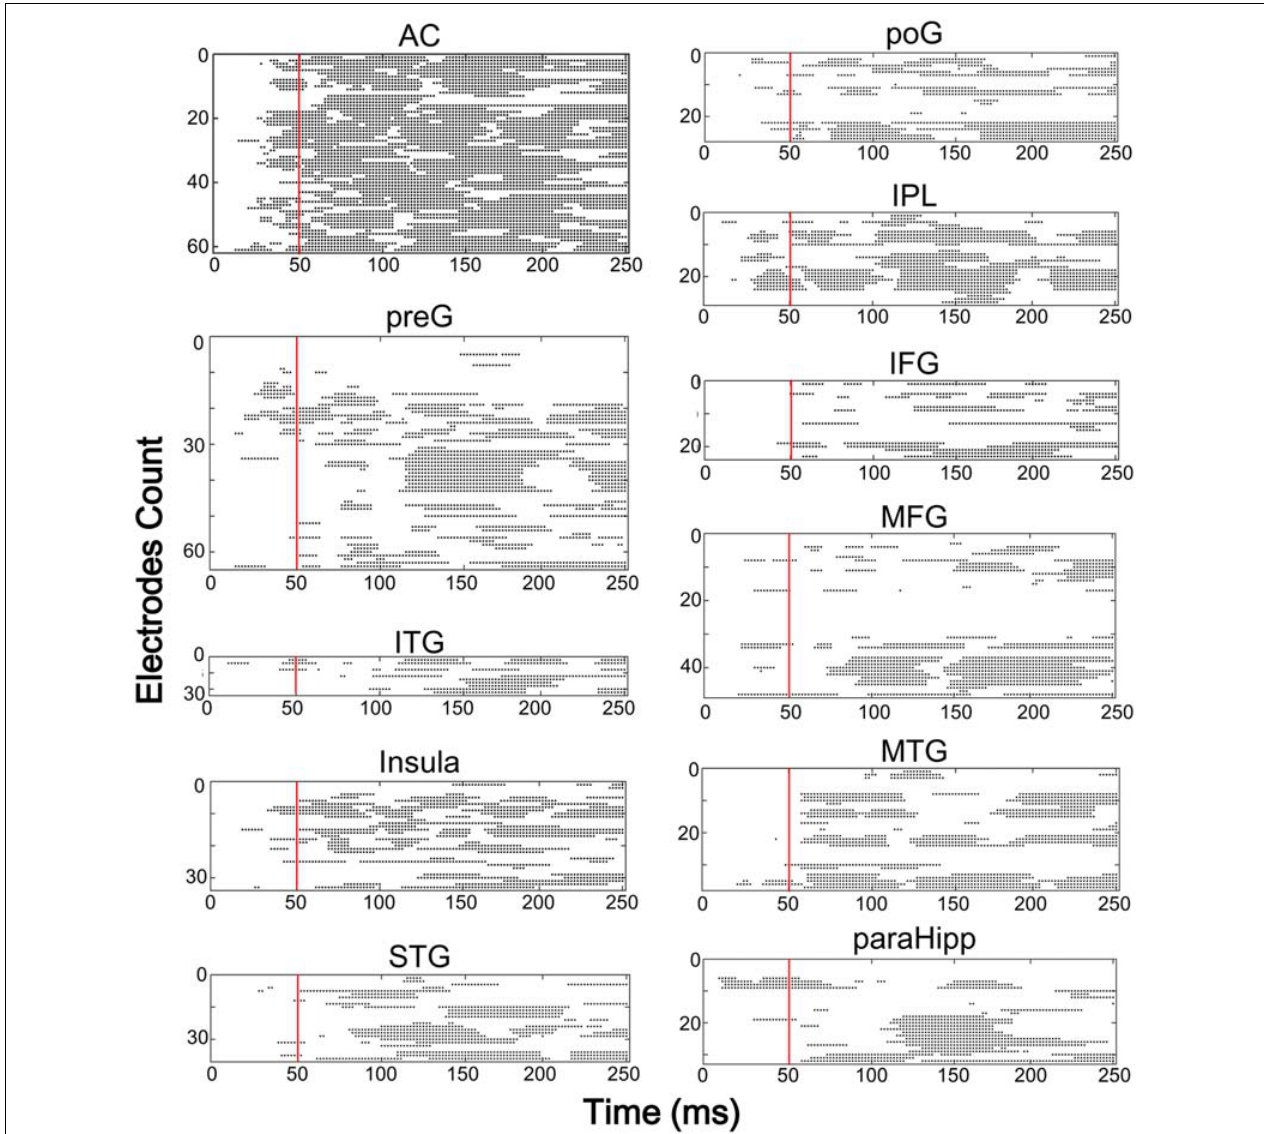
FIGURE 4 | The results of single trial statistical analysis within each electrode, respectively. Each line represents the significance across time and each black dot represented this time point was significantly different with the baseline. Red lines , time points at 50 ms. AC , auditory cortex; PreG , precentral gyrus; STG , superior temporal gyrus; poG , postcentral gyrus; IPL , inferior parietal lobule; IFG , inferior frontal gyrus; MFG , middle frontal gyrus; MTG , middle temporal gyrus; ParaHipp , para-hippocampus; ITG , inferior temporal